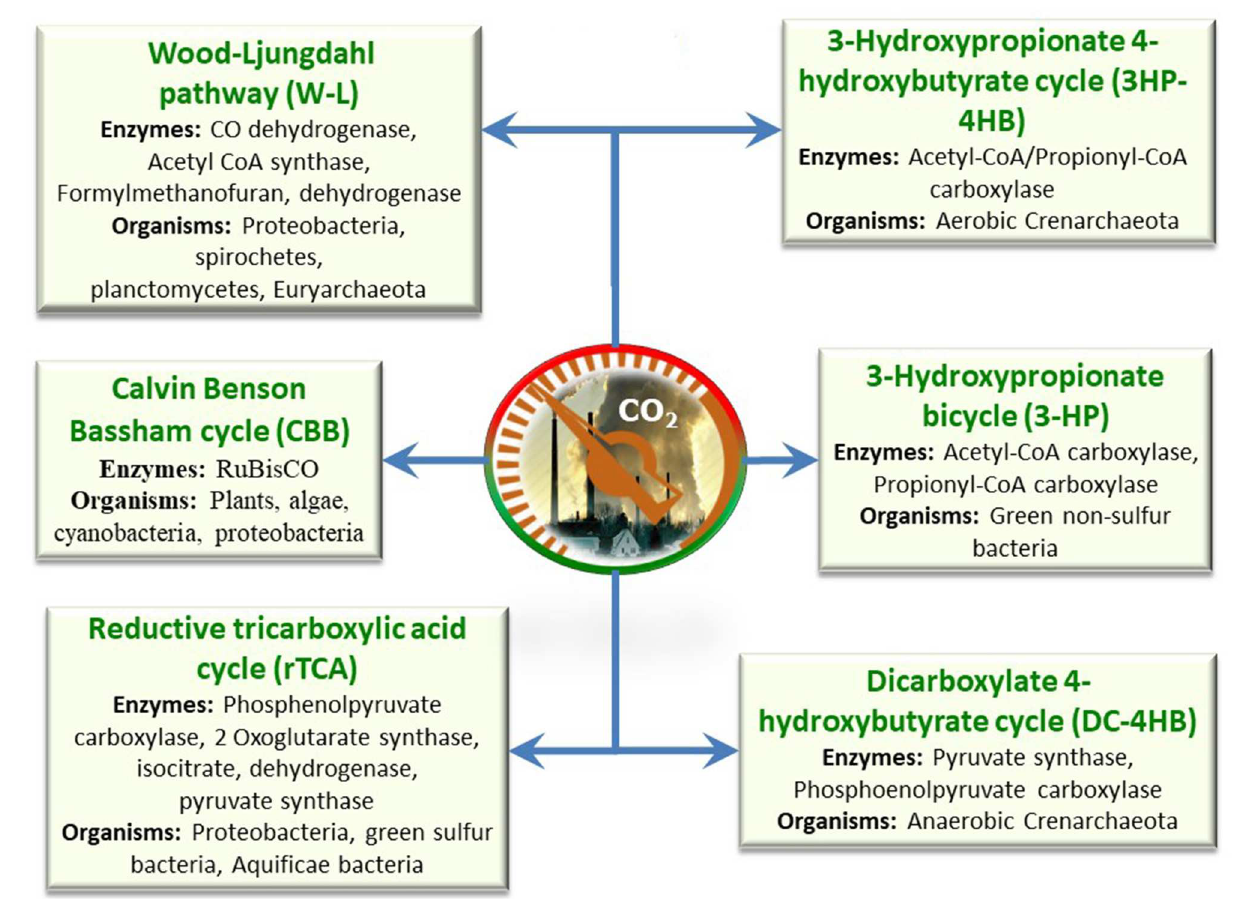
FIGURE 5 | Various biological pathways for CO 2 metabolism in microbes for carbon fixation.